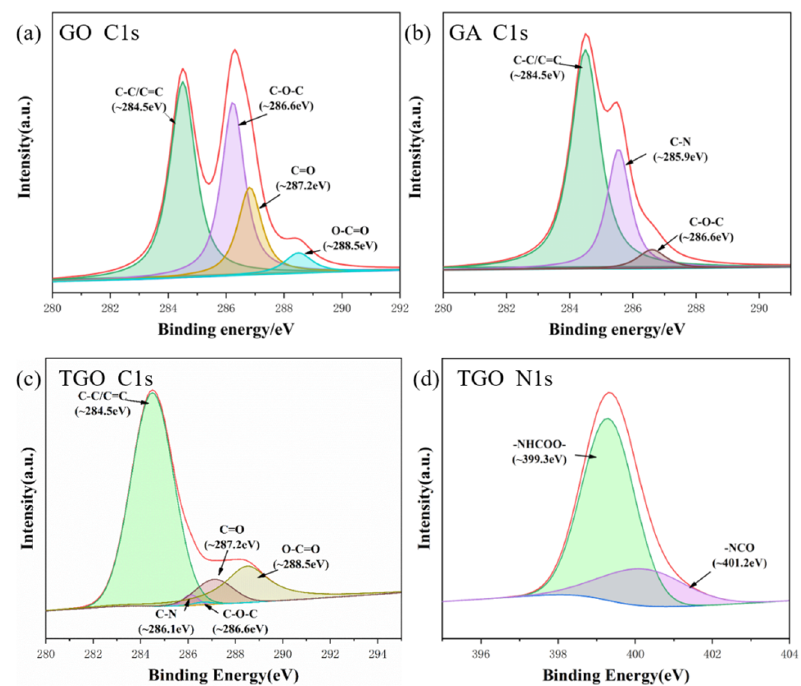
Figure 4. ( a–c ) High-resolution C1s XPS spectra of GO, GA and TGO; ( d ) High-resolution N1s XPS spectra of TGO.